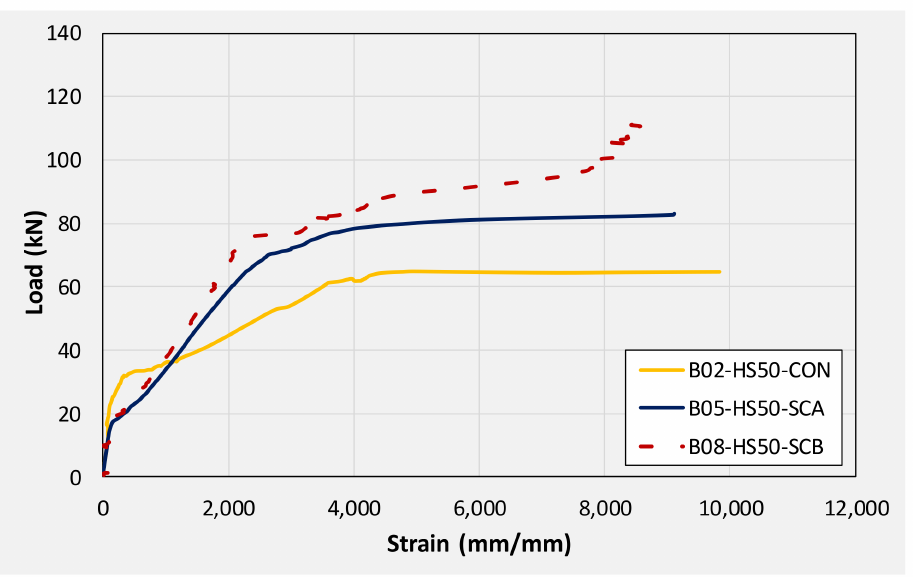
Figure 24. Monitored positive steel strain in beams with 50 mm internal square openings.